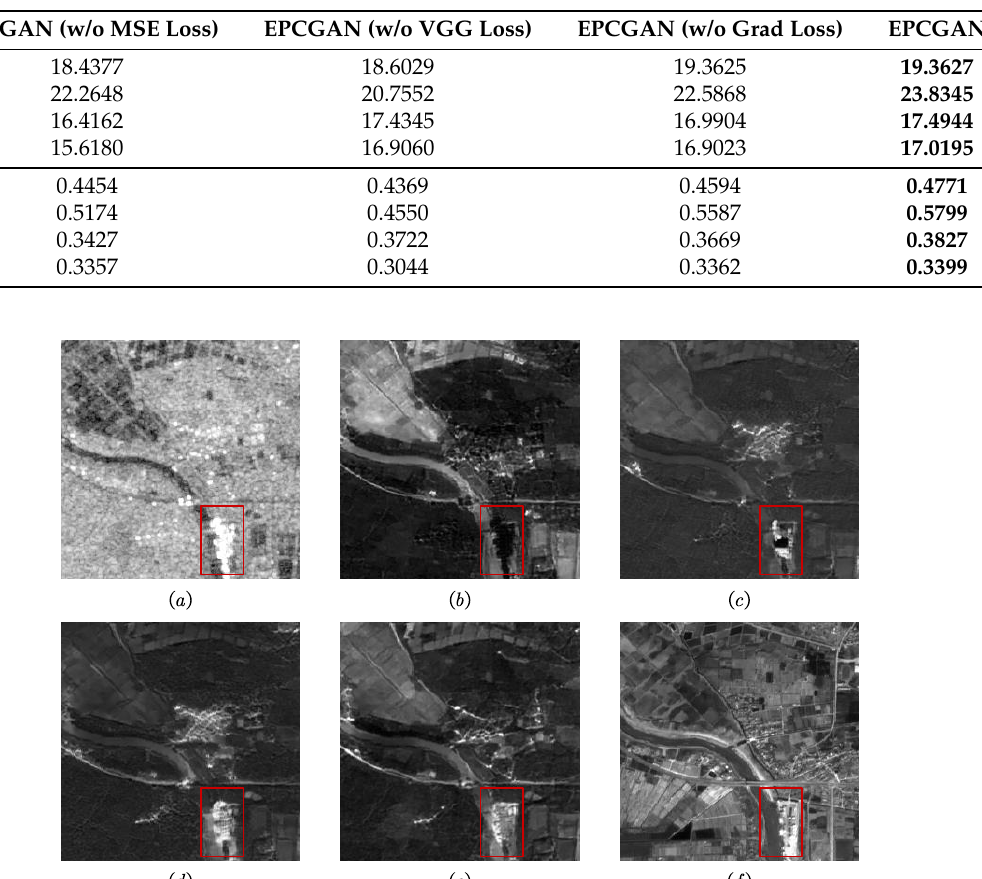
Table 6. Image quality assessment (IQA) results of different loss functions. The best values for each quality index are shown in bold.